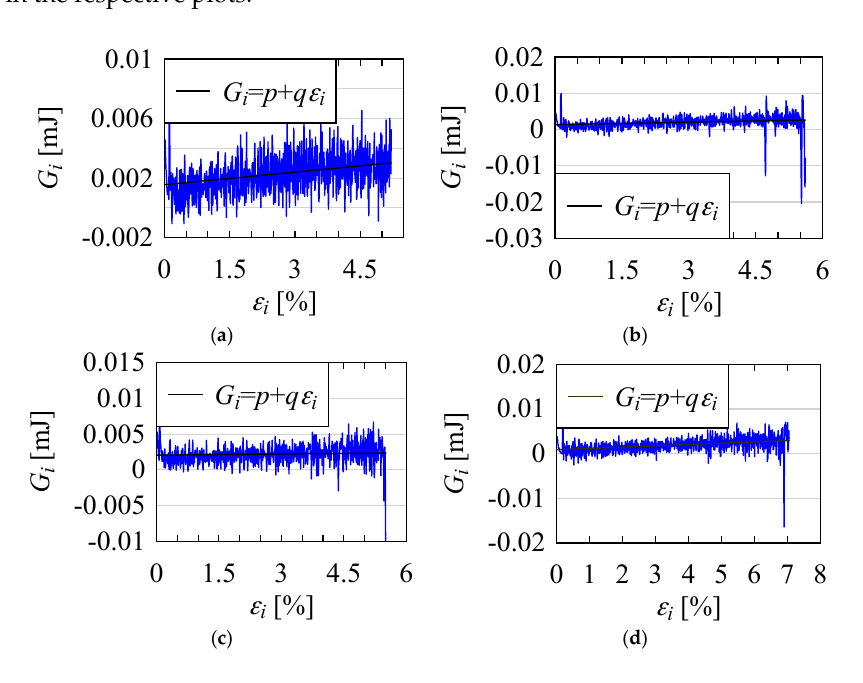
Figure 6. Energy difference patterns of four jute yarn specimens. ( a ) p = 0.001562, q = 0.0002815; ( b ) p = 0.001332, q = 0.0002262; ( c ) p = 0.00207, q = 0.00005224; ( d ) p = 0.0008807, q = 0.000292.